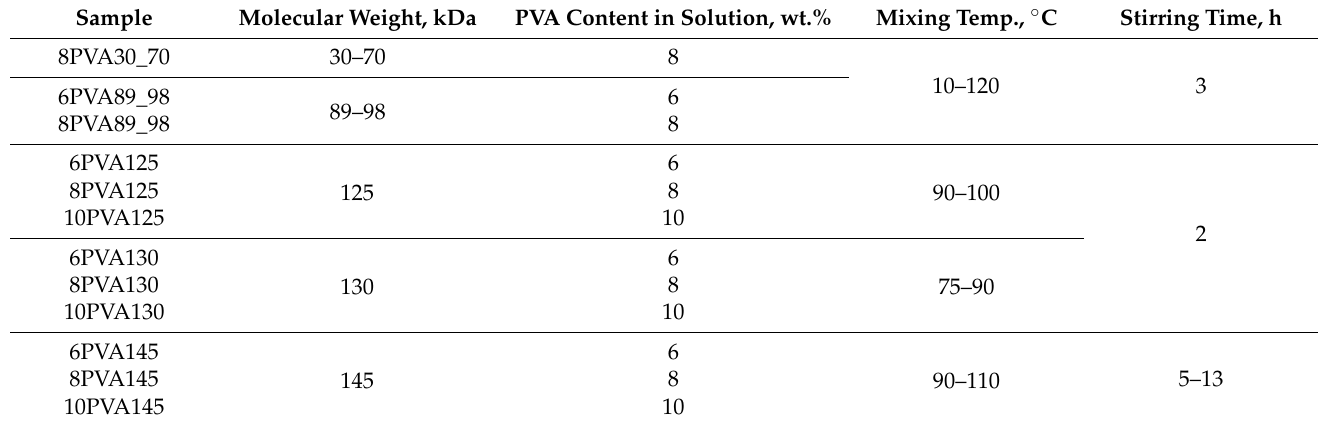
Table 1. The time and temperature used for PVA solution preparation.